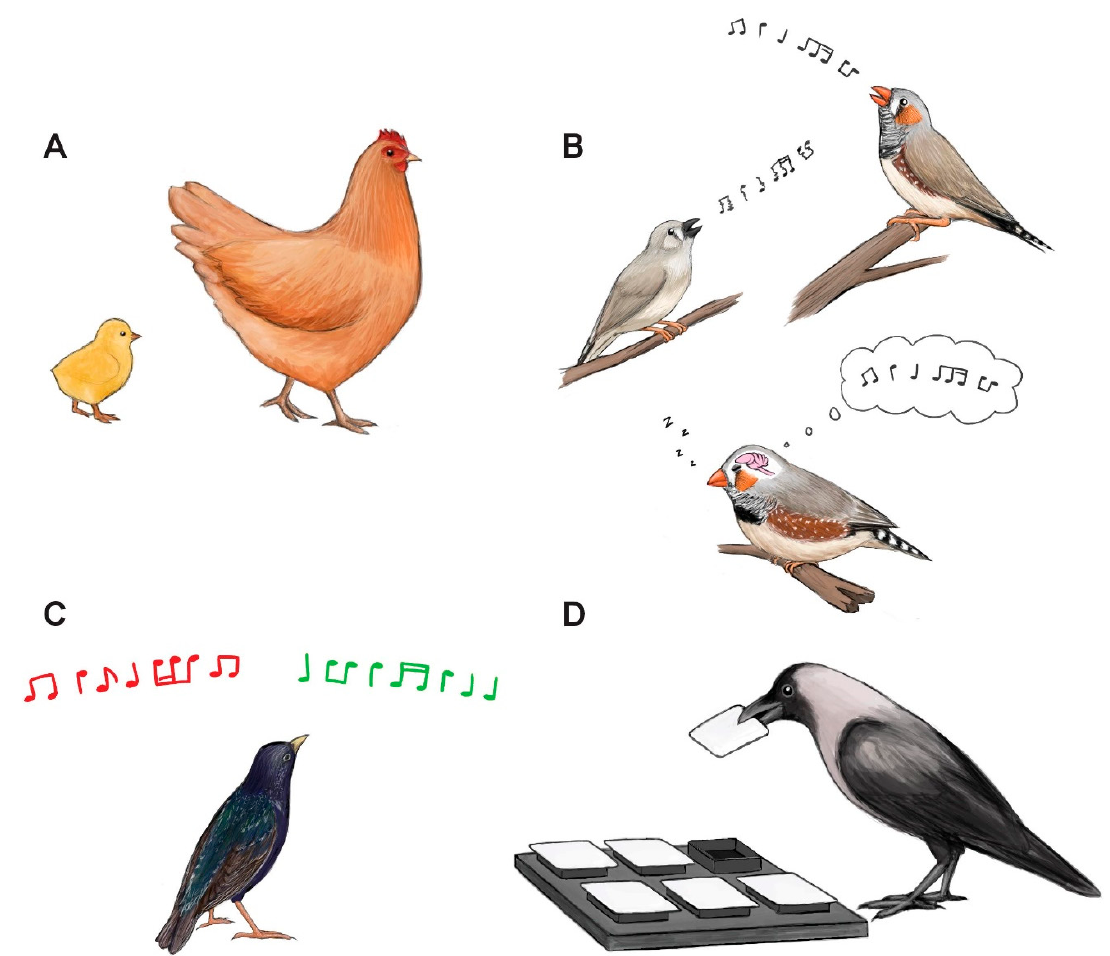
Figure 3. Multiple cognitive processes in birds depend on sleep, including: ( A ) imprinting in domestic chicks, ( B ) develop- mental song learning and neuronal replay in zebra finches, ( C ) auditory discrimination learning in European starlings and ( D ) spatial learning in Indian house crows. Illustrations by Laura X. Tan.